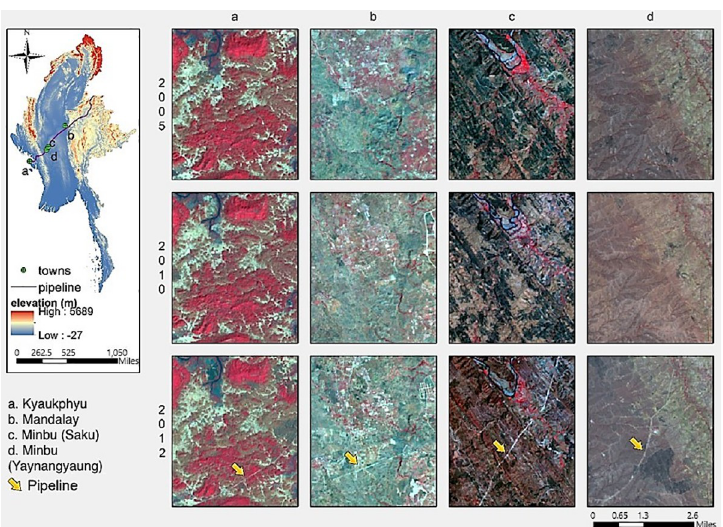
Fig 3. False-color composite images of the three sites between pre- and post- pipelines construction. The yellow arrow shows the appearance of the pipelines in 2012 images traversing all three locations. 2005: Landsat 5(R:3, G:3, B:1), 2010: Landsat 7(R:3, G:3, B:1), 2012: Landsat 8 (R:4, G:3, B:2). (Landsat-5, 7and 8 images courtesy of the U.S. Geological Survey;